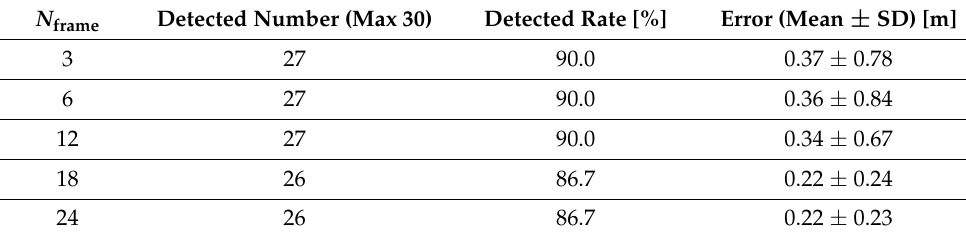
Table 4. Result of leakage position estimations with different N frame .